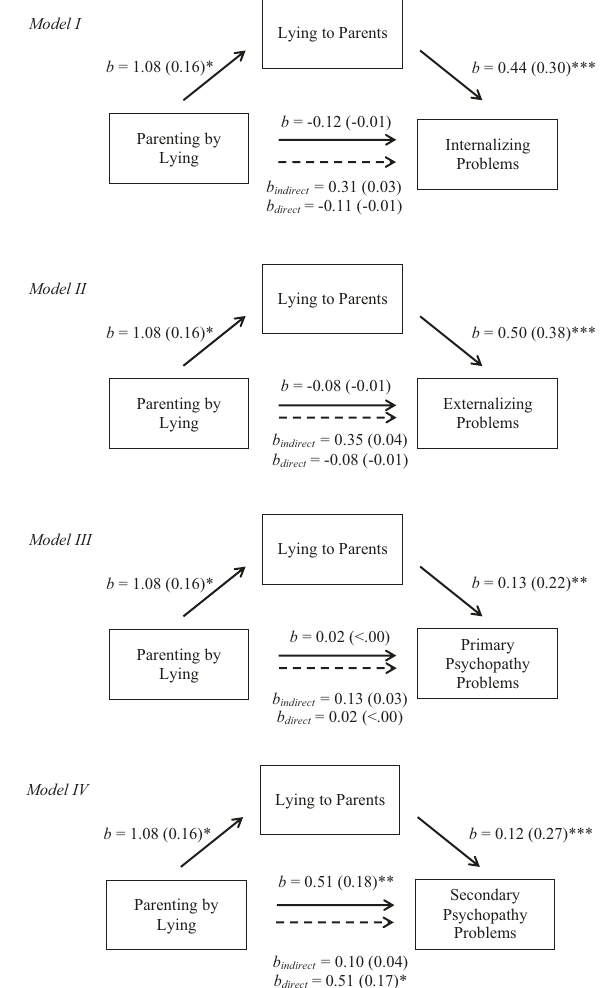
Fig. 2 Mediation models between exposure to parenting by lying ( X ) and each psychosocial outcome variable ( Y ), with lying to parents ( M ) as the mediator. Model IV re fl ects a signi fi cant complementary mediation model. The solid lines represent the simple linear regression results, whereas the dashed line represents the bootstrapped (in)direct effects of X on Y after controlling for M . The values in brackets indicate the standardized